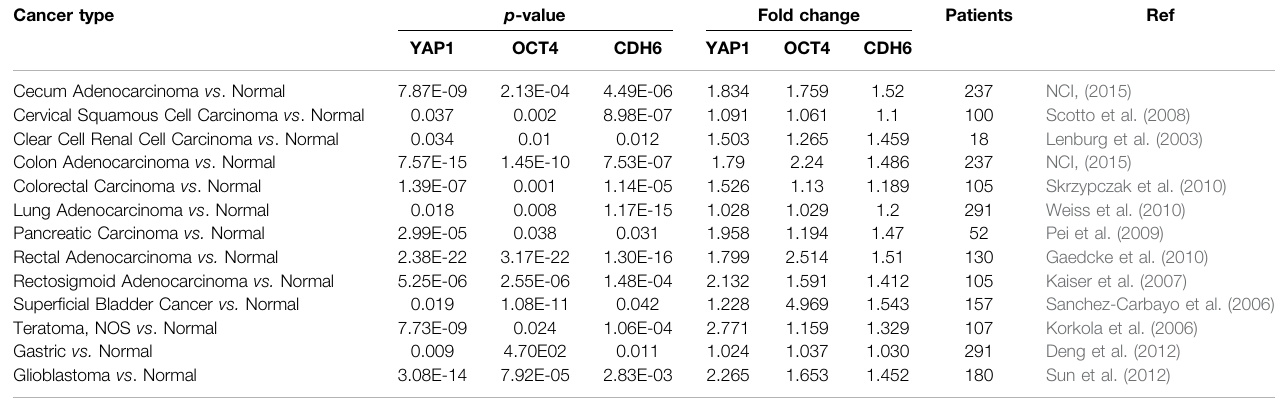
TABLE 1 | 56 clinical cancer cohorts from Oncomine and TCGA databases.